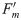
Constant actinic light PAM experiment.(a) Comparison between the predicted and measured fluorescence fluxes Fm′ (triangles), F0′ (squares) and F′ (circles) in response to a constant light experiment. The grey-shaded area represents the light intensity. (b) Measured value of qNPQ, defined as (Fm−Fm′)/Fm′, during the recovery phase of experiment Exp2 along with predicted values using different modelling assumptions. The dashed lines consider a first-order model to represent NPQ; the solid line considers the NPQ as the combined effect of two interdependent processes with different time scales.